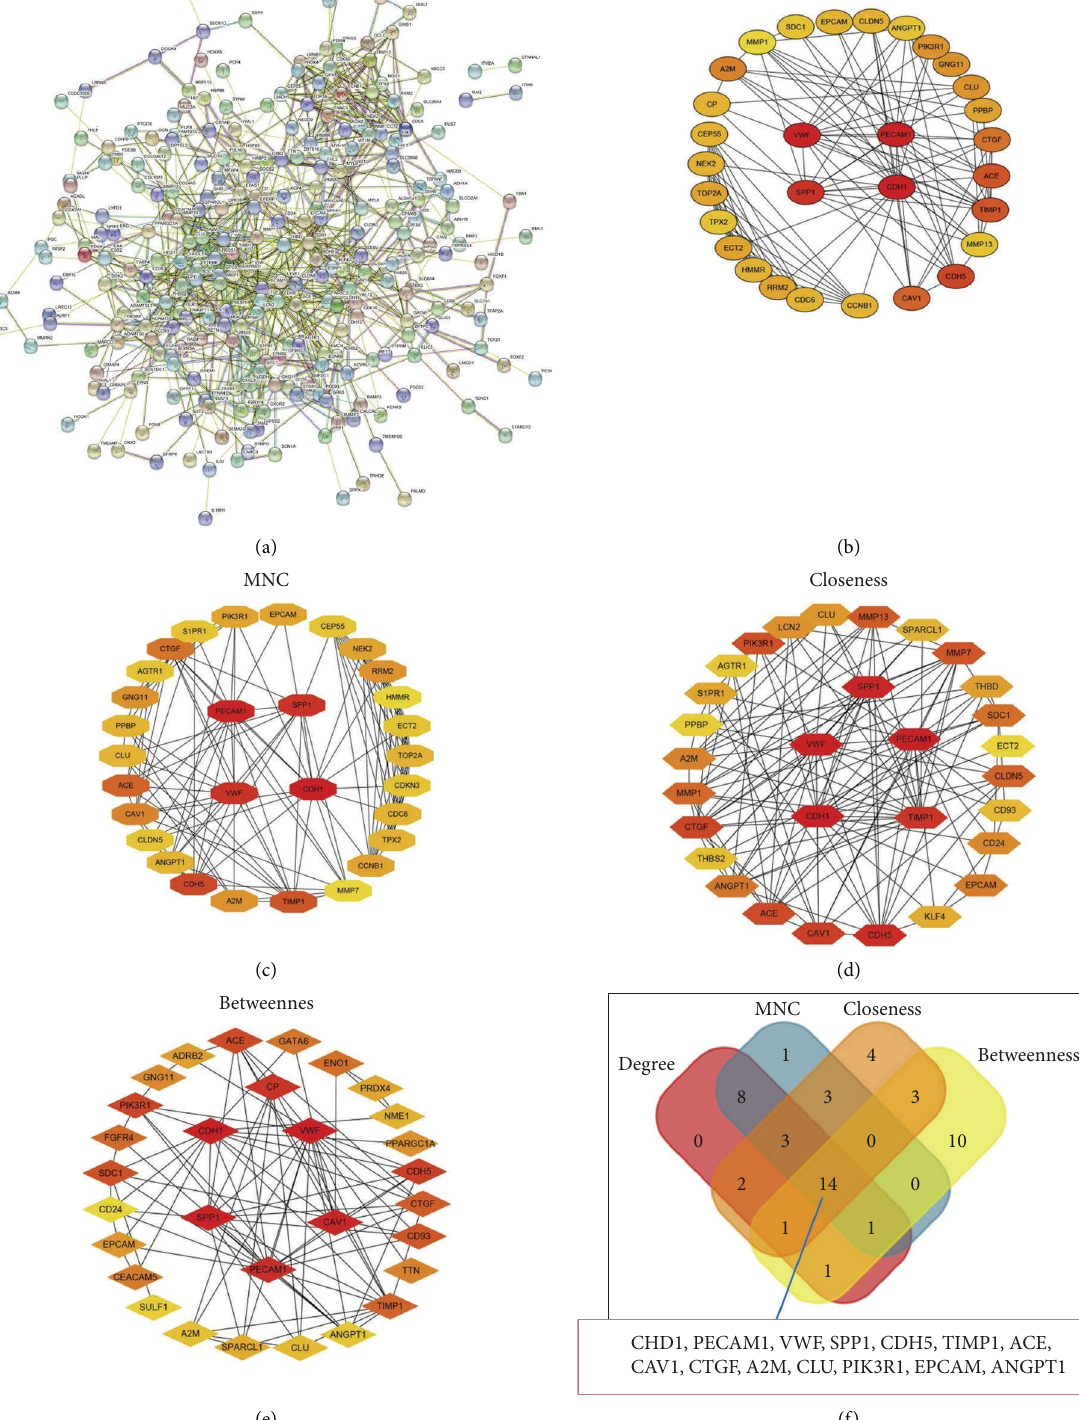
Figure 5: Determining the hub genes. (a) PPI network of 312 promising target genes in lung adenocarcinoma based on the string website. (b–e) Find hub genes with the CytoHubba plugin in Cytoscape software. Four diferent metrics were used: DEGREE, MNC, closeness, and betweenness. (f) A Venn diagram used to identify 14 hub genes in lung